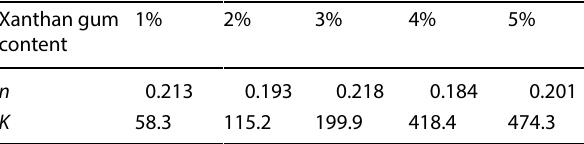
Table 1 The numerical values computed for both n and K in Eq. 1 Xanthan gum content